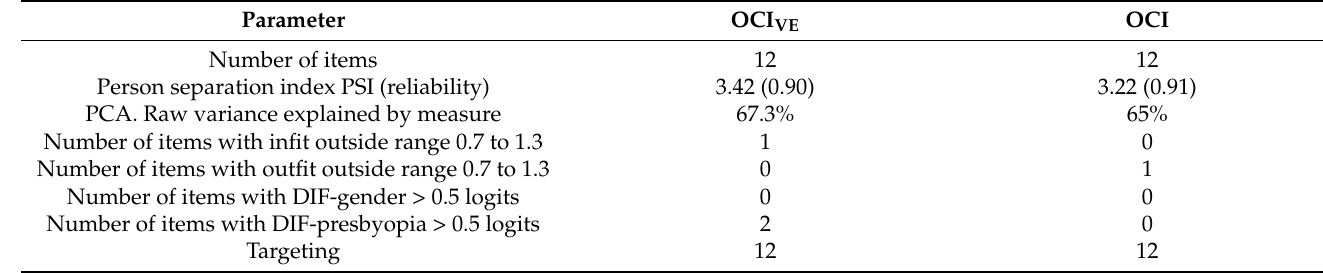
Table 5. Psychometric Properties of the Spanish and English OCI